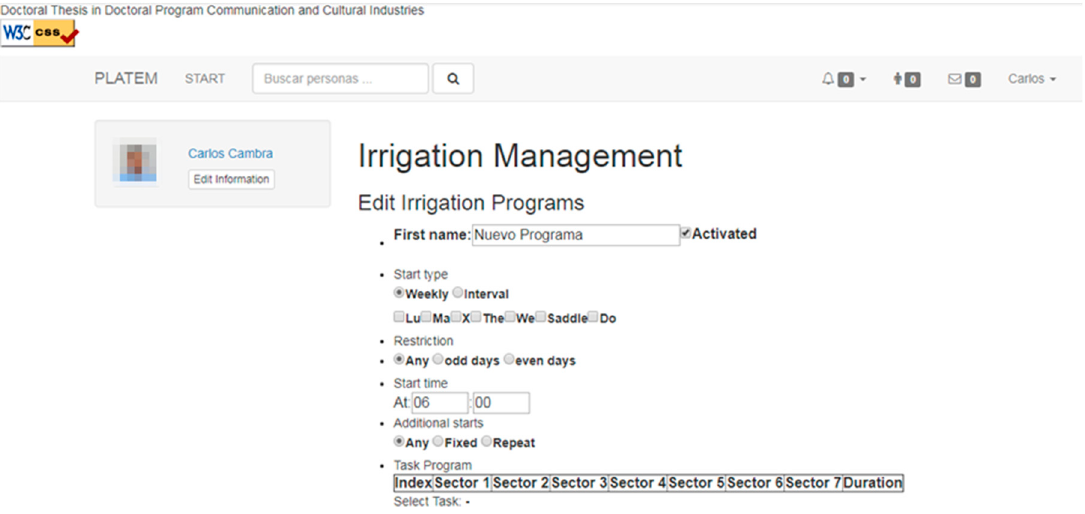
Figure 18. Irrigation edition parameters view.